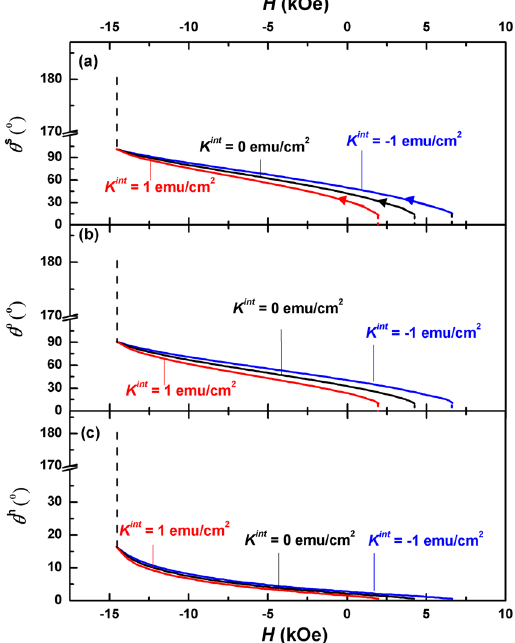
Figure 4. Evolution of θ h ( a ), θ 0 ( b ) and θ s ( c ) of a Nd 2 Fe 14 B (10 nm)/ α -Fe (6 nm) multilayer for various interface anisotropy as the applied field changes from nucleation to pinning. The arrows in Fig. 4(a) represent the direction of demagnetization